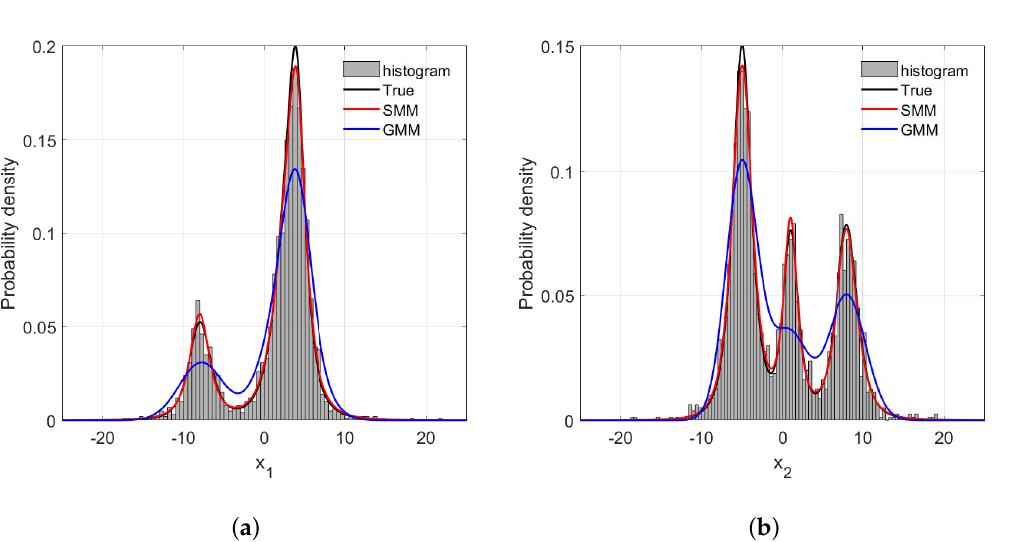
Figure 5. The frequency histogram and probability density curve with 1% rate outliers: ( a ) x 1 direction; ( b ) x 2 direction.